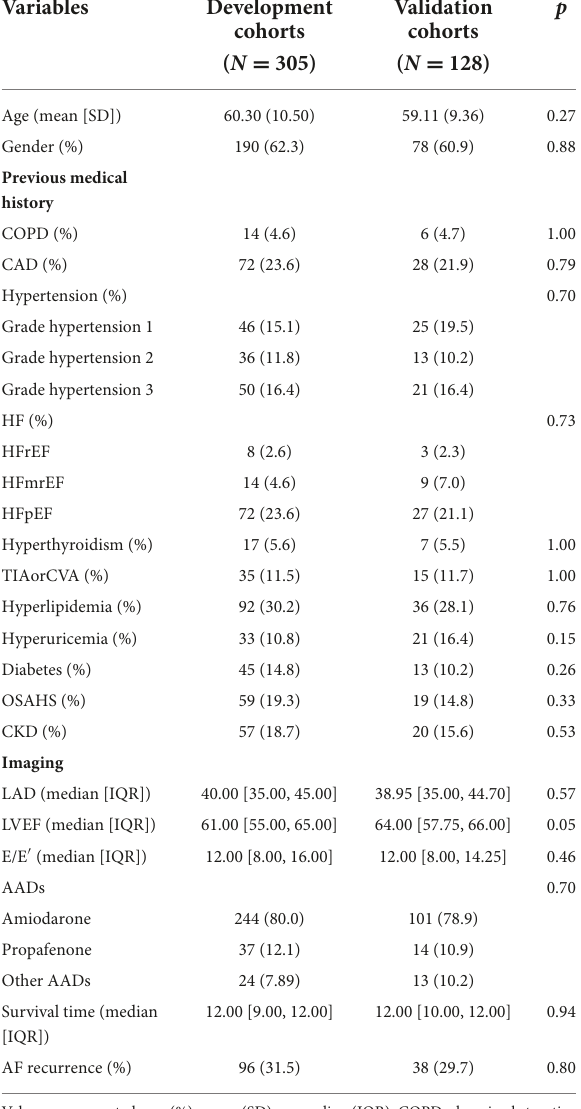
TABLE 2 Multivariate Cox regression of atrial fibrillation (AF) recurrence risk between 3 and 12 months after radiofrequency catheter ablation (RFCA) for patients with paroxysmal atrial fibrillation